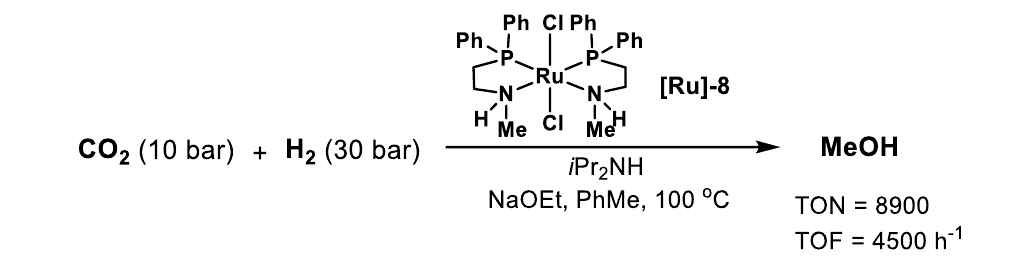
Figure 9. Ruthenium and amine auxiliaries catalyzed hydrogenation of CO 2 .